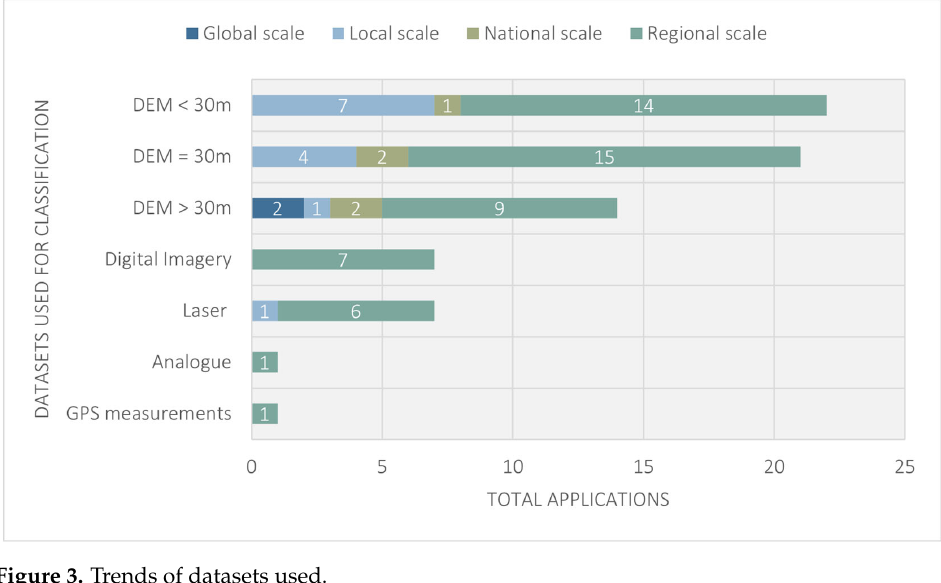
Figure 3. Trends of datasets used.